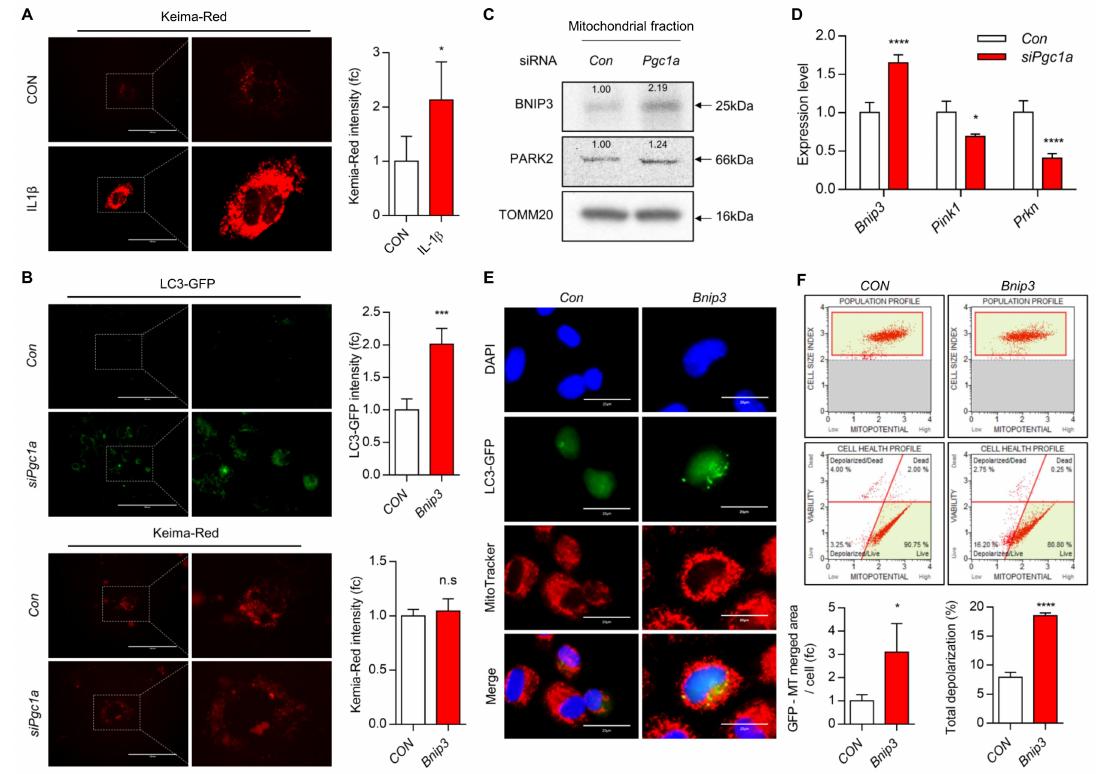
Figure 2. PGC1 α suppression is associated with BNIP3-induced mitophagy during OA pathogenesis. ( A ) Representative images of Keima-Red with or without IL-1 β in iMACs ( n = 4; Scale bars, 100 µ m). Results are representative of at least five independent experiments. ( B ) Representative images of LC3-GFP and Keima-Red with the introduction of siPgc1a into iMACs ( n = 5; Scale bars, 100 µ m). The results are representative of at least four independent experiments. ( C ) The mitochondrial protein expression level of BNIP3, PARK2 with the introduction of siPgc1a into iMACs. TOMM20 was used for loading control. Each protein level was measured using ImageJ software and normalized by TOMM20 expression level and indicated by a fold change. ( D ) The transcription level of mitophagy genes was analyzed using qRT-PCR ( n = 3). ( E ) Representative images of LC3-GFP and MitoTracker with the introduction of Bnip3 into iMACs ( n = 5; Scale bars, 20 µ m). Results are representative of at least five independent experiments. ( F ) Mitochondria membrane potential level was analyzed using MUSE Cell Analyzer ( n = 3). Values were expressed as means ± s.d. An unpaired t -test or one-way ANOVA was used for statistical analysis. n.s., non-significant, * p ≤ 0.05, *** p < 0.001, **** p <